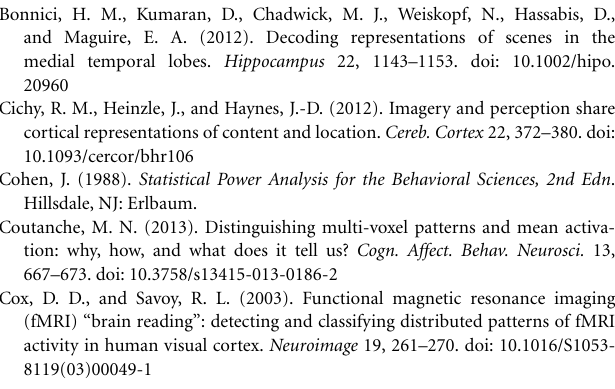
Supplementary Figure 1 | Comparison of classification using different numbers of voxels per region of interest. Classification analyses for individual scene-selective ROIs in the main text ( Figure 3 ) used 80 voxels per ROI per hemisphere, for a total of 160 voxels per ROI. Here, those analyses are repeated using 10, 20, 40, 80, 160, or 320 voxels per ROI per hemisphere. If a participant did not have enough in-brain voxels in a given ROI, all of their in-brain voxels in a 10mm radius were used, so some analyses contain fewer voxels than the stated number for some participants. Classification performance varied with region, condition, and experiment, but in most cases performance reached a plateau by 80 voxels per ROI per hemisphere, and in some cases performance worsened at higher voxel counts (e.g., in OPA for imagery classification), likely due to the inclusion of white matter or other noise voxels. P -values represent uncorrected two-tailed t -tests against chance (0.5) at each point, color-coded according to experiment. Error bars represent s.e.m. Supplementary Table 1 | Contributions of mean activation levels to classifier performance. All p -values represent two-tailed t -tests against a chance AUC value of 0.5. For each region, experiment, and type of analysis, classifier performance is reported for the original data (as reported in the main manuscript and Table 1 ), the data with the mean activation value (across voxels, within each trial) subtracted out, a classifier based only on mean activity levels, and the data after Z-scoring across features (within each trial). Experiment 1: all degrees of freedom ( df ) = 15. Experiment 2: all df = 11. AUC = area under ROC